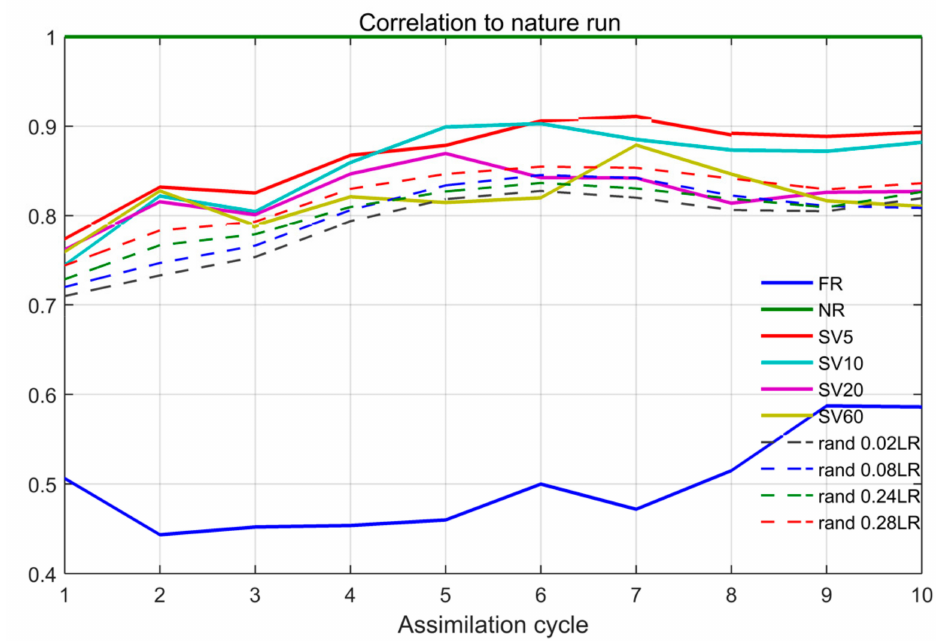
Figure 13. Correlation of analyses run to the Nature Run for the 10 cycles of the 5-day-long-assimilation windows where the observation networks were based on the correlation map of Figure 4 and the SVD computed for di ff erent optimization times: 5 days, 10 days, 20 days, and 60 days. The dashed lines represent the results for the random strategy plus a fixed minimum distance. The analyses are compared to each other and to the Free Run (blue